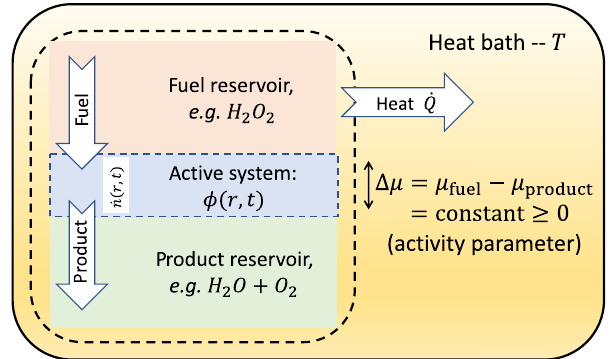
FIG. 1. Schematic representation of an active system (blue) put in contact with reservoirs of chemical fuel (red) and product (green) which set a constant, homogeneous chemical potential difference Δ μ in the active system. This representation is essentially a nonequilibrium grand-canonical ensemble for the active system (details in the Appendix A). Within our framework, Δ μ embodies the driving parameter which controls the non- equilibrium terms in the dynamics (1) – (4) for the active density field ϕ and the rate of fuel consumption _ n . The active system and the chemical reservoirs are surrounded by the thermostat (yellow) which maintains a fixed temperature T . The fluctuations of ϕ and n lead to dissipation of heat Q into the thermostat, which quantifies the energetic cost to maintain the whole system away from